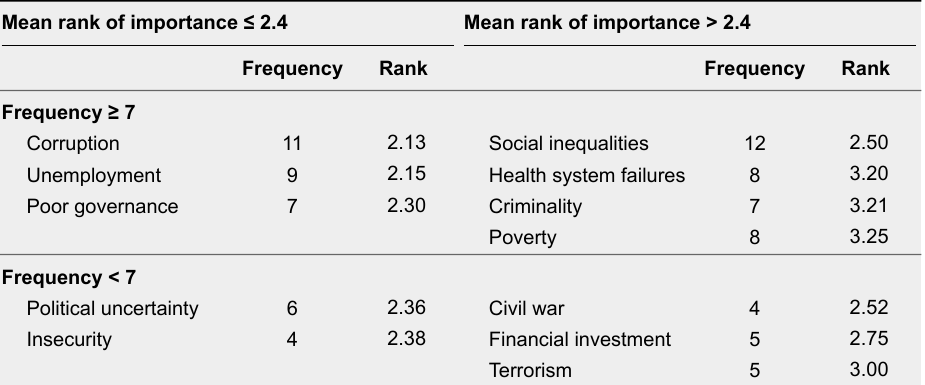
Structure of the Social Representation of Risk Based on Data Yielded by the Pilot Study